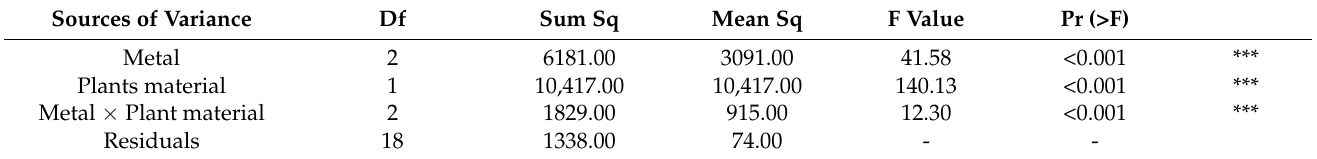
Table 4. Analysis of variance for plant material dying under the influence of metals. Df—degrees of